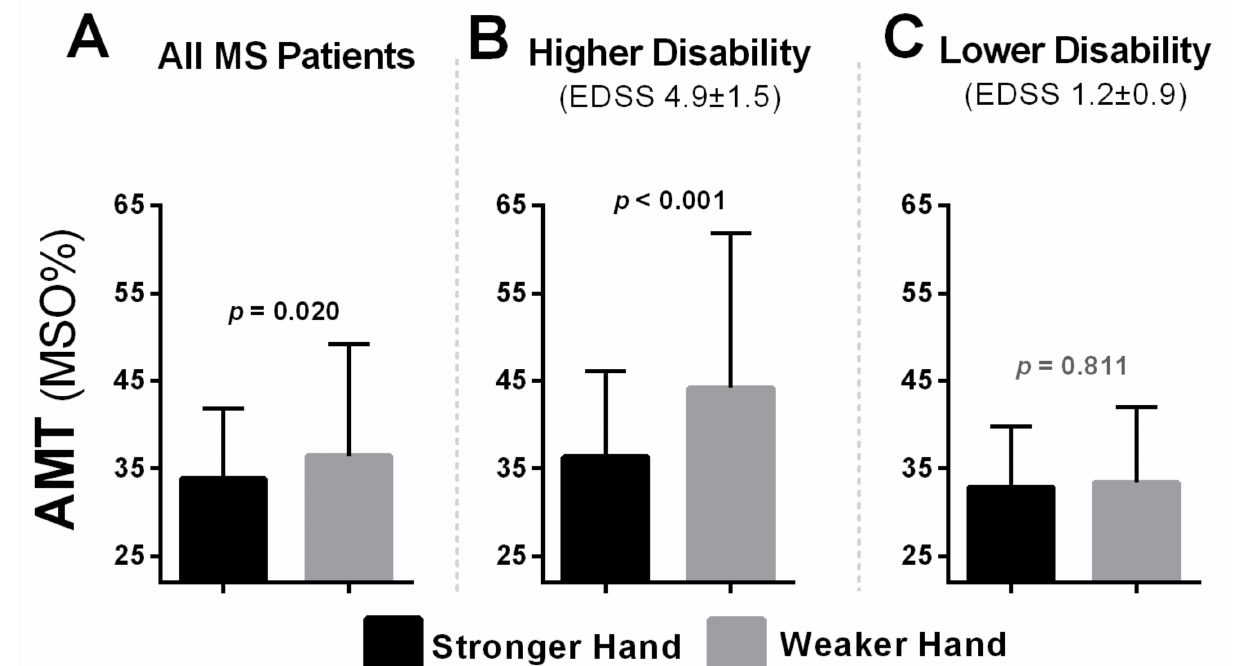
Figure 7. Corticospinal Excitability (CSE) Differences Between Hemispheres. ( A ) Considering all participants in the same analysis, significantly lower CSE was noted in the hemisphere corresponding to the weaker than to the stronger hand. When separating participants into groups of higher (EDSS ≥ 3) vs. lower (EDSS < 3) level of disability, ( B ) only the group with higher level of disability demonstrated significantly higher active motor threshold (AMT) (i.e., lower CSE) in the hemisphere corresponding to the weaker compared to the stronger hand. ( C ) No significant difference between hemispheres was noted for AMT in the group with lower level of disability. Error bars represent one standard deviation ( ± SD) of the mean. EDSS, expanded disability status scale (MS severity; 0 = no disability, to 10 = death due to